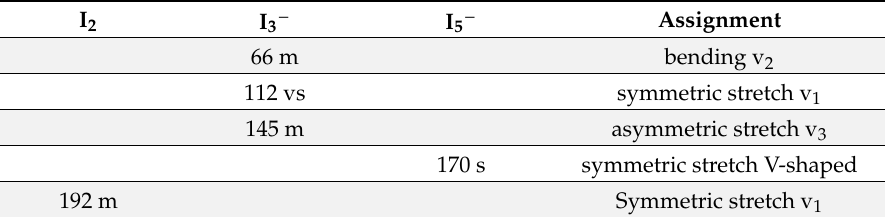
Table 1. Breakdown and assignment of Raman bands observed in Figure 9.